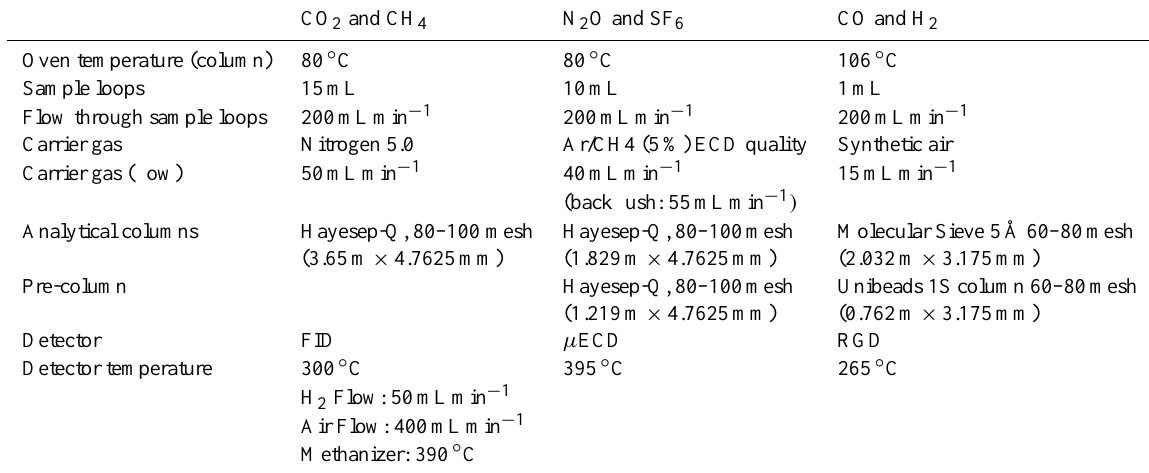
Table 2. Settings of the GC